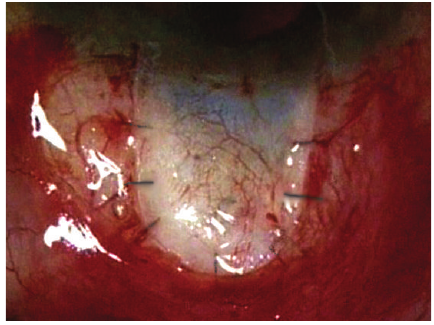
Figure 7: Watertight suture of the superficial sclera flap.